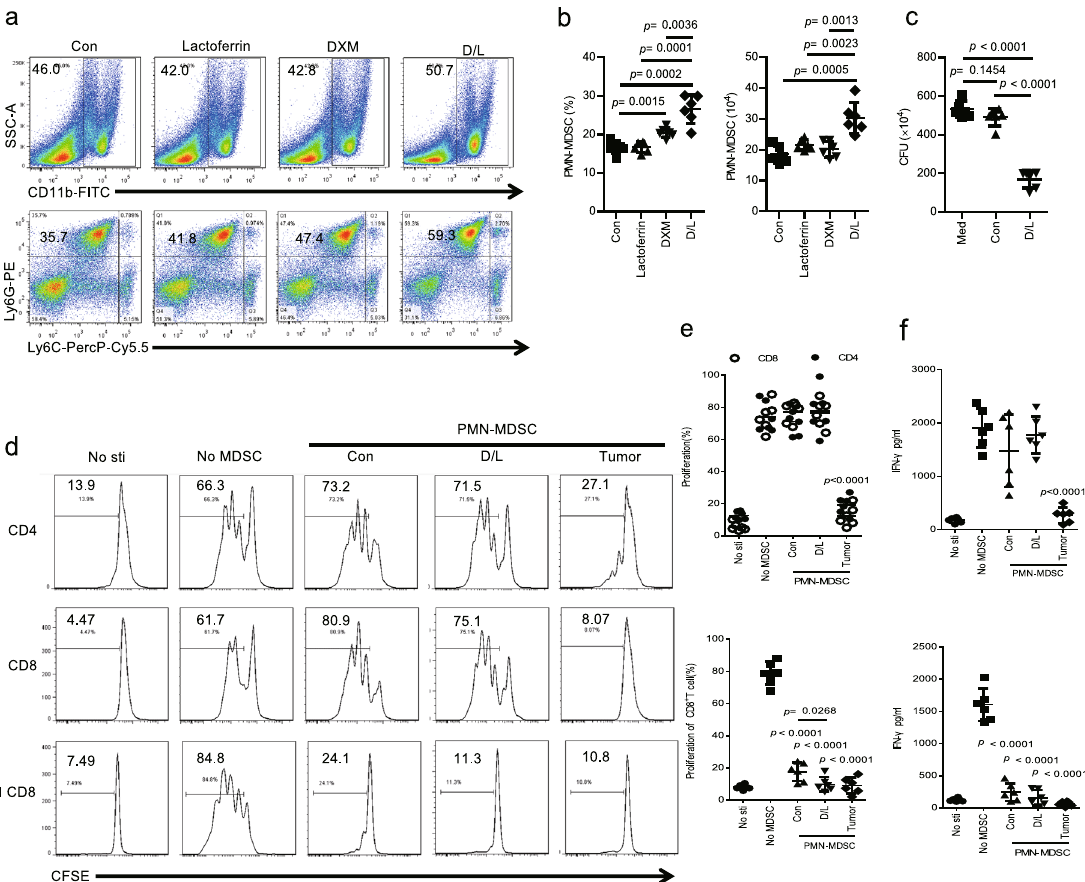
were treated with lactoferrin, DXM, combination of DXM and lactoferrin (D/L), or PBS vehicle (Con) in the presence of GM-CSF and IL-6 for 3 d.